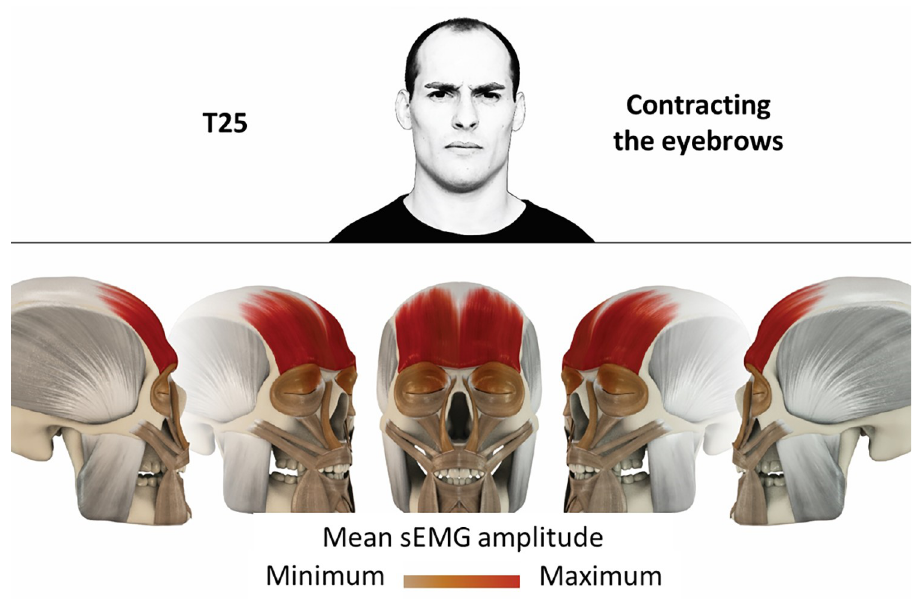
Fig 26. Color-coded facial muscle activation pattern of task T25. Contracting eyebrows. Animation by Jonas Laustro¨er.